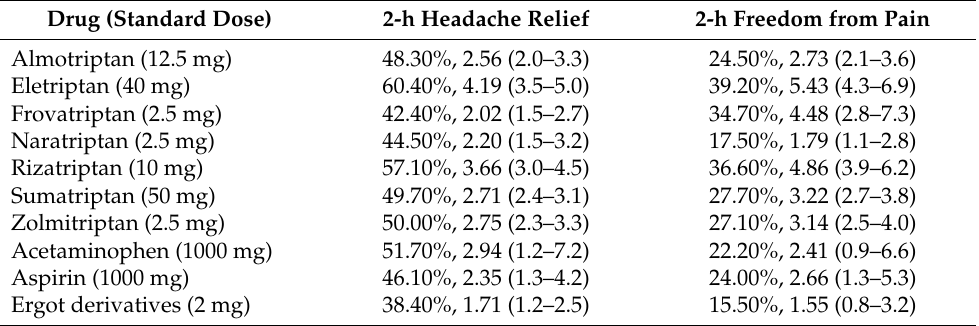
Table 1. Percentage of Patients, Odds ratio (OR) and 95% Credible Interval (CrI) with headache relief or freedom from pain at 2 h with a standard dose of triptans and not specific symptomatic treatments administered for oral